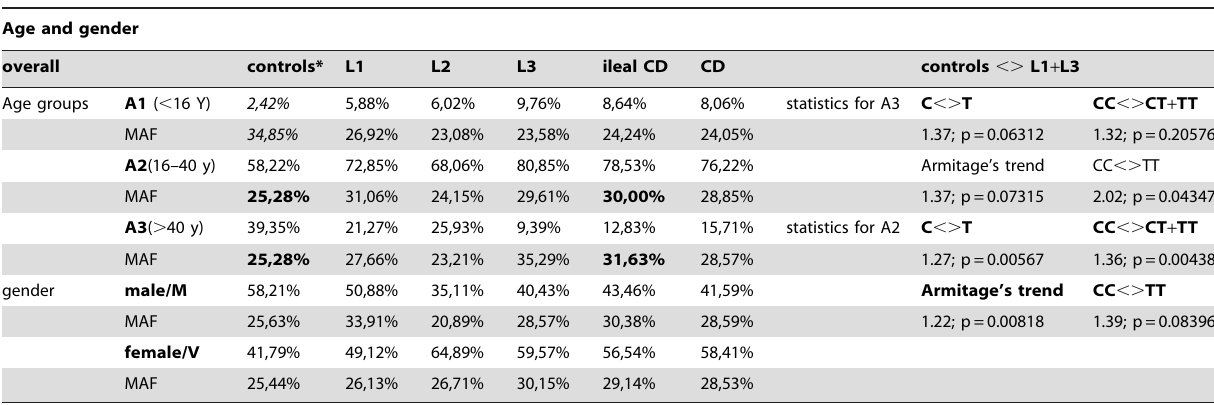
MAF=minor allele frequency. * controls A1 only from